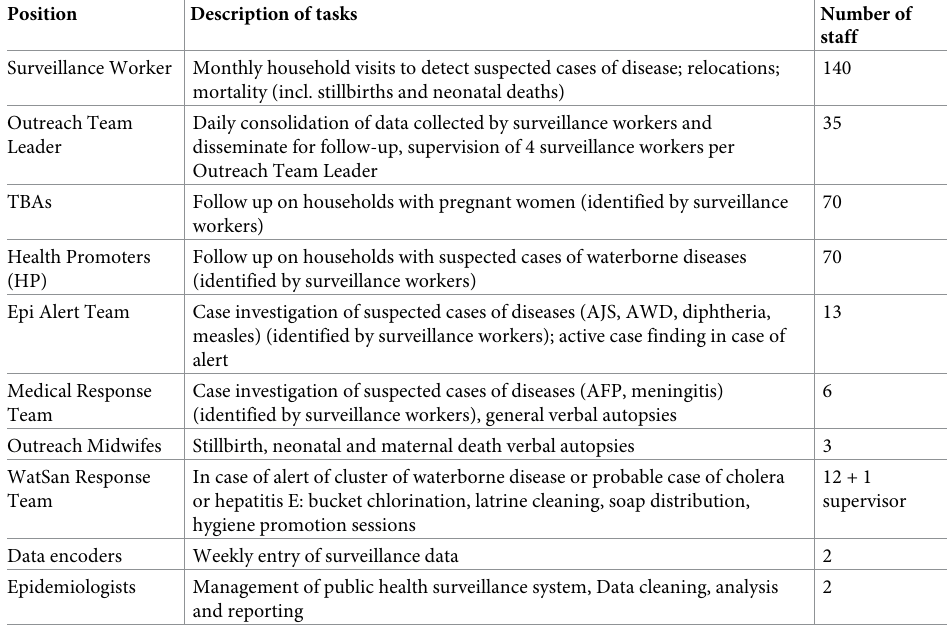
Table 2. Description of human resources engaged in MSF’s public health surveillance in Cox’s Bazar, Bangladesh, week 20–44, 2019.